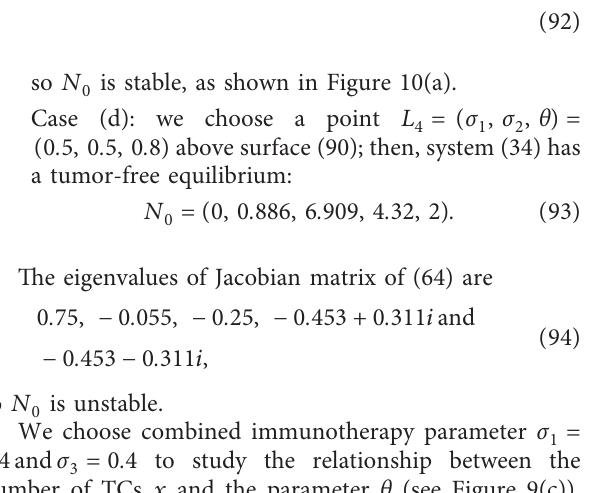
Figure 9: (a) Choose different σ � 0 . 1 , 0 . 5 , 0 . 8. Stability region of N ∗ and Hopf bifurcation curve in θ − σ 3 the left of the curve and unstable to the right of the curve. (b) Combined immunotherapy surface. N � 0 . 4and σ � 0 . 4, the bifurcation diagram of x with respect to θ for system (34). Hopf bifurcation point above the surface. (c) When σ 1 3 , σ ) � ( 0 . 4 , 0 ) , ( 0 , 0 . 4 ) , ( 0 . 4 , 0 . 4 ) , ( 0 . 7 , 0 . 7 ) . The bifurcation diagram of x with respect to appears at θ ∗ CI � 0 . 727. (d) Choose different ( σ 1 3 θ (the stable steady state is represented by the blue curve, and the unstable one corresponds to the red